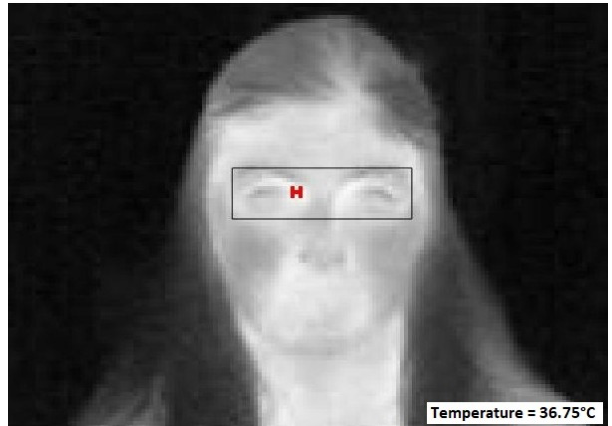
Figure 17. Sample of the temperature data of an image and its detected inner canthus temperature, where the red * belongs to the pixel of the inner canthus detected.